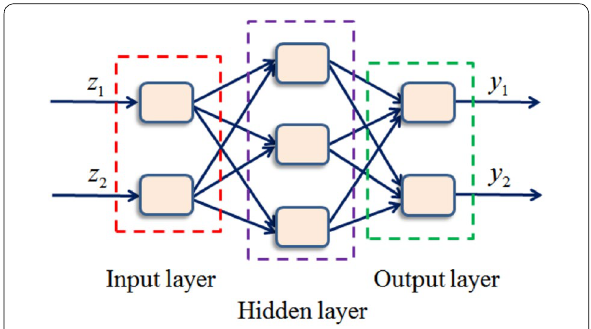
Figure 4 BP neural network